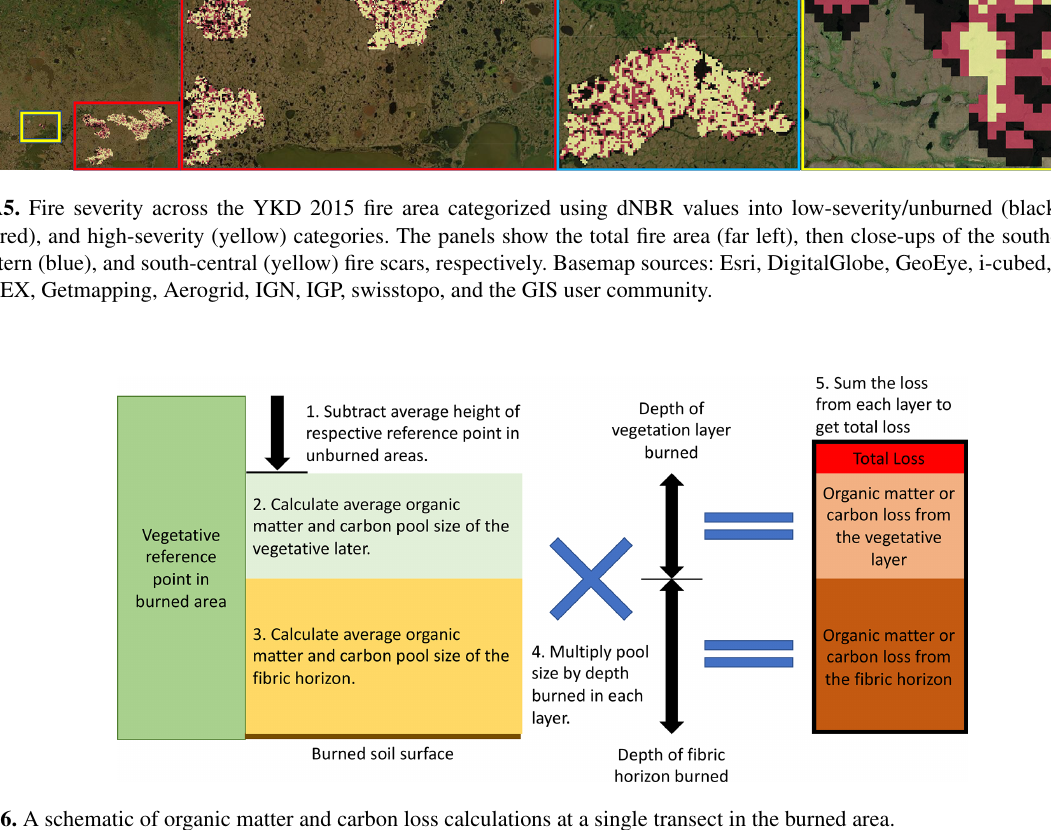
Figure A6. A schematic of organic matter and carbon loss calculations at a single transect in the burned area.